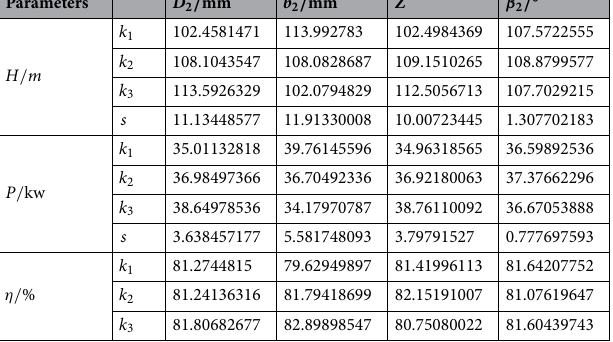
Table 5. Range analysis results.